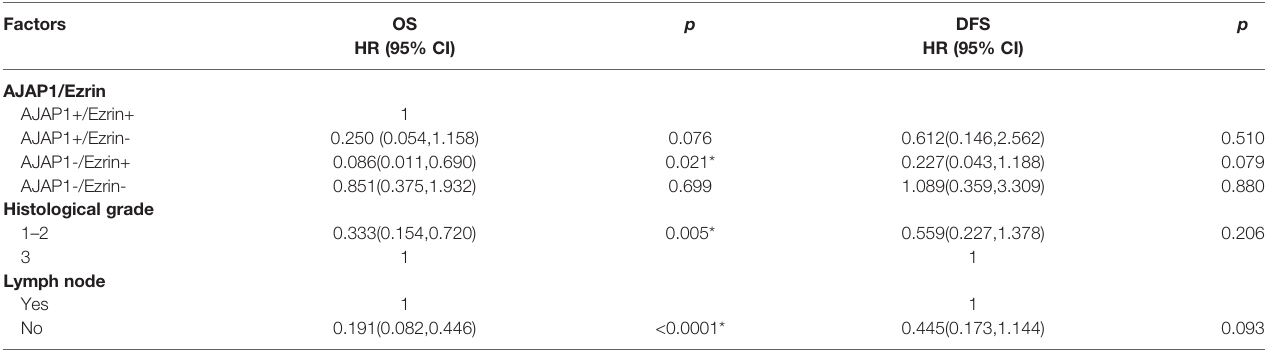
TABLE 4 | Multivariate analysis of OS and DFS in breast cancer